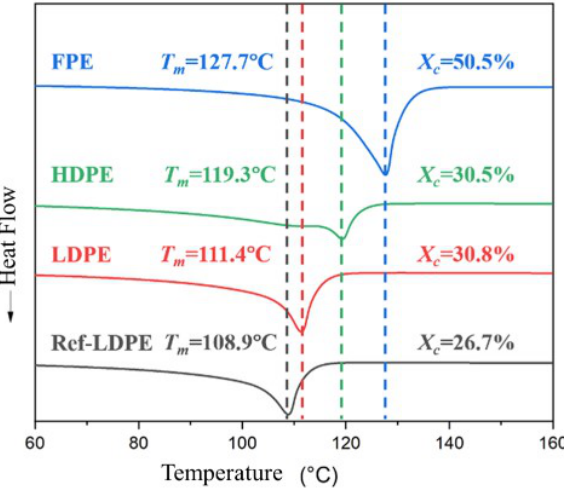
Figure 2. DSC curves of unaged PE samples in the N 2 atmosphere.